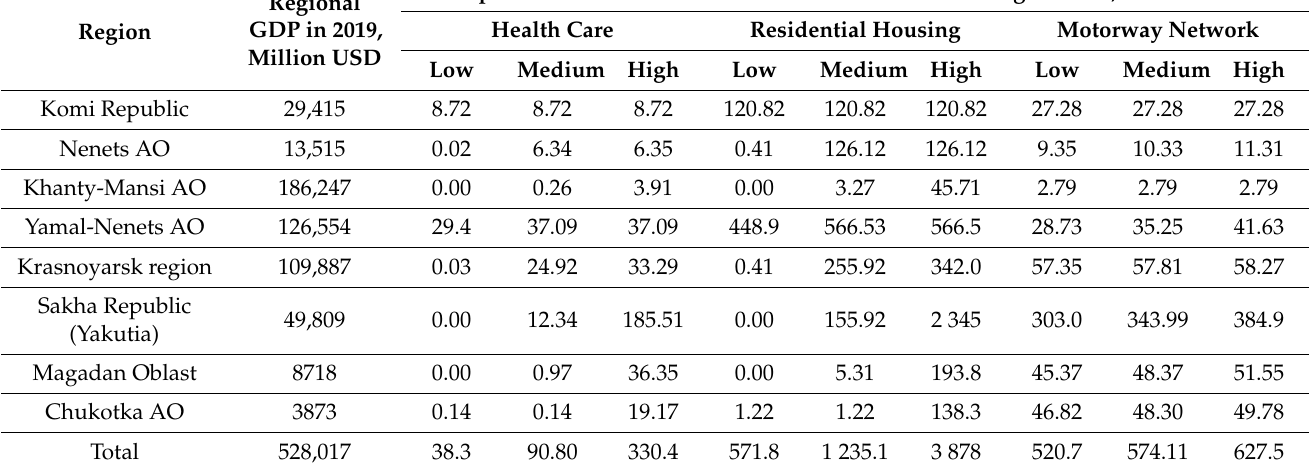
Table 2. Economic losses due to the maintenance of the social infrastructure built on permafrost under low, medium, and high permafrost degradation